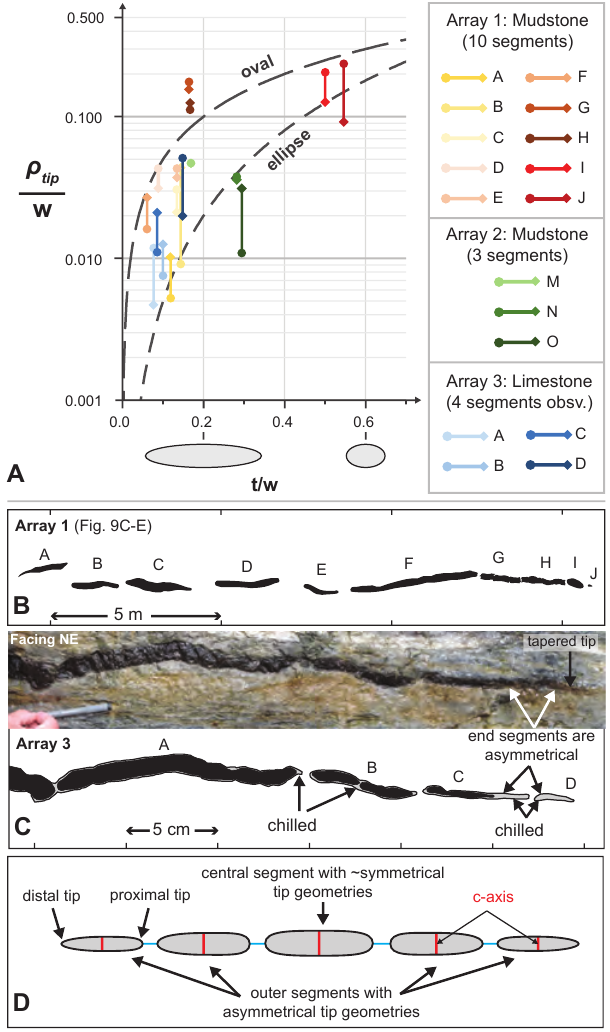
Figure 7: Geometrical characterisation of individual segment geometries within an array. [A] Plot to define segment geometries: segment tips are displayed as cir- cles and diamonds (for left and right tips, as observed in outcrop), individual segments are shown as linked sym- bols and the line length correlates to segment asym- metry about its c-axis (longer line = more